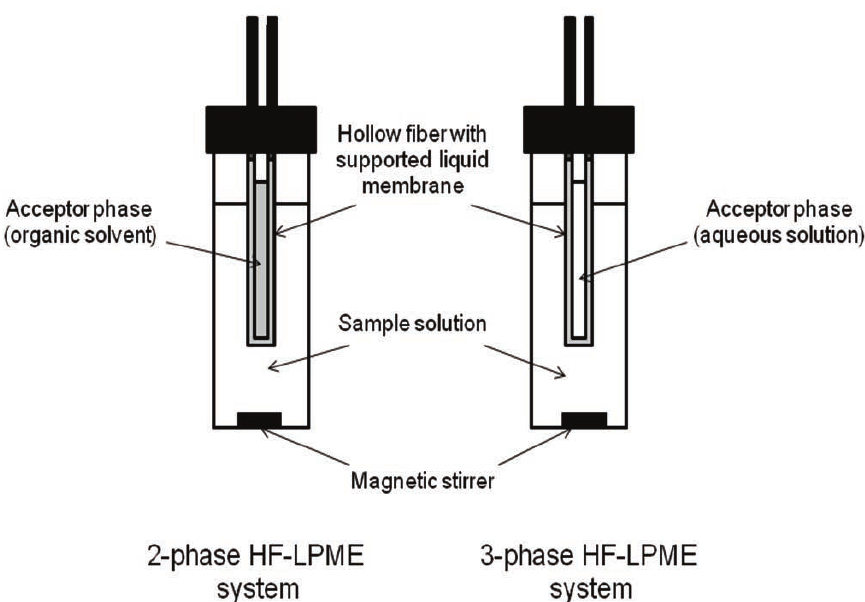
Figure 5. Schematic illustration of